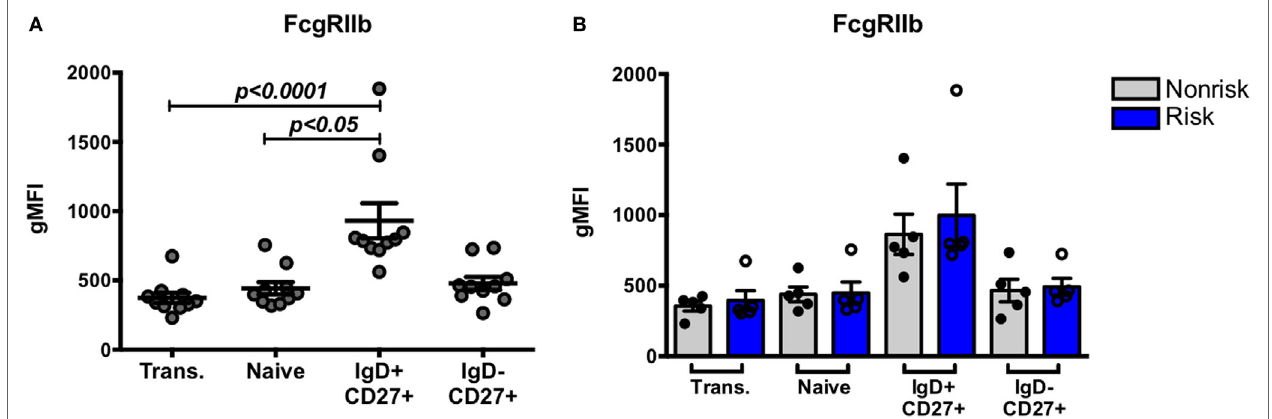
FigUre 7 | Interferon regulatory factor 5 risk alleles do no affect baseline Fc γ RIIb expression in B cell subsets. B cell subsets were analyzed similarly as in Figure 1 . (a) Flow cytometric results of Fc γ RIIb protein expression in combined B cell subsets and (B) separated by haplotype. p < 0.05 and p < 0.0001 by Friedman test with Dunn’s multiple comparisons test (a) , p = ns by Mann–Whitney test for each B cell subset (B)